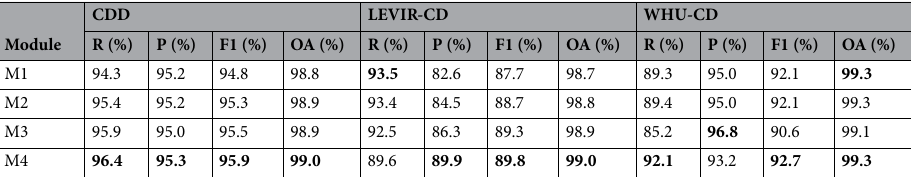
Table 8. Ablation experiment of MSFA module (the best performance is emphasized in